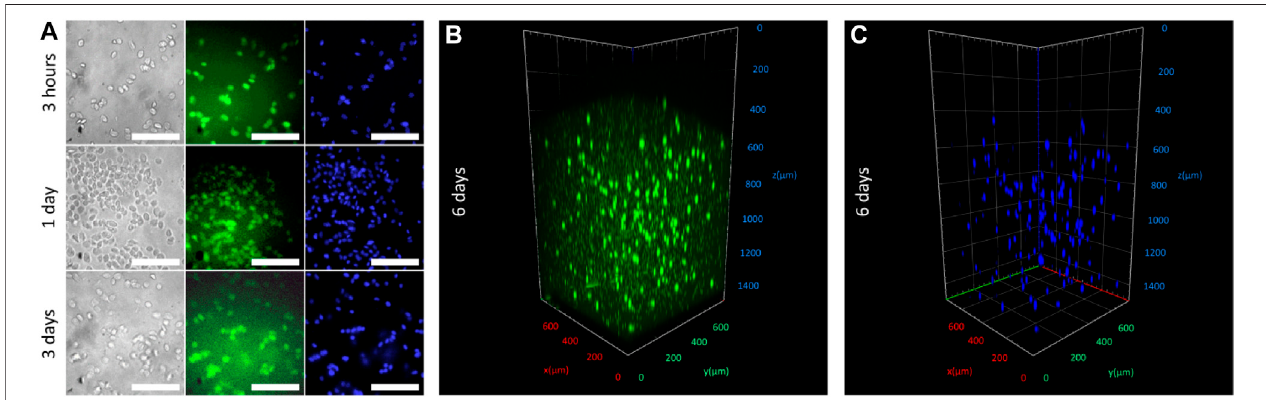
FIGURE 5 | (A) In vitro imaging after 3, 24, and 72 h incubation of HaCaT-laden fi bers stained with calcein AM ( fl uorescence labeled alive cells, in green) and Hoechst 33342 (cell nucleuses, in blue). Scale bar 100 µm. (B,C) Fluorescence confocal imaging of fi bers acquired on day 6 of incubation stained with calcein AM and Hoechst